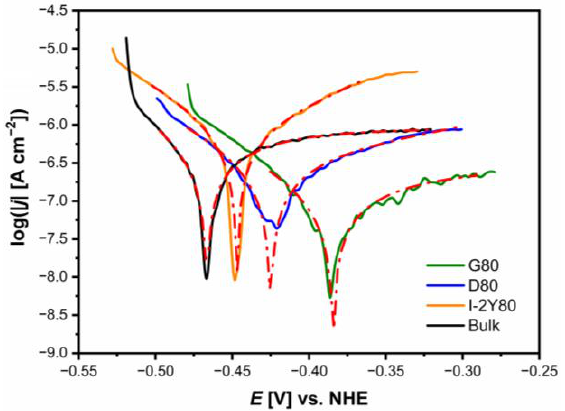
Figure 8. Tafel curves for the CpTi G2 cellular lattice with TPMS architecture of G80, D80, I-2Y80, and the bulk electrode in 0.1 M KOH solution saturated with O 2 at 25 °C. Continuous lines represent the experimental data and red dash dotted lines are the fitting results obtained using the Tafel extrapolation. Table 3. Corrosion resistance parameters determined by the Tafel extrapolation method for the CpTi G2 cellular lattice with TPMS architecture of G80, D80, I-2Y80, and the bulk electrode in 0.1 M KOH solution saturated with O 2 at 25 °C (see Figure 8). CpTi